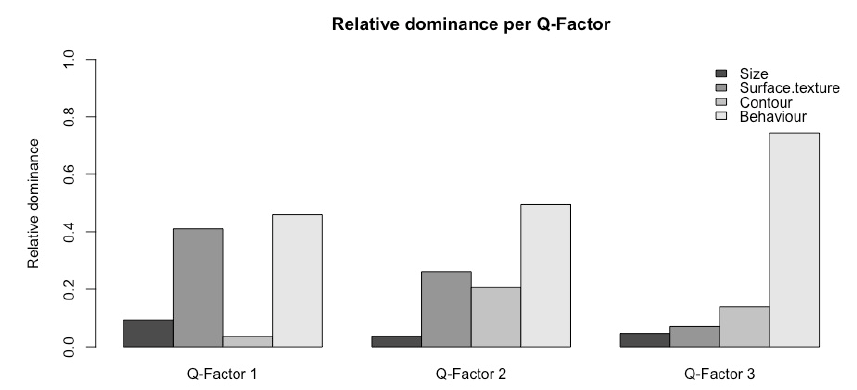
Figure 10. The dominance of variables for each Q-factor.